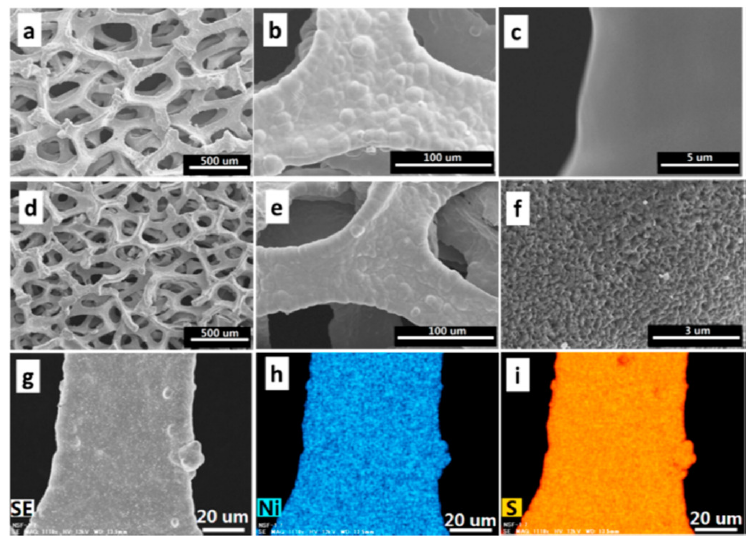
Figure 10. SEM images of ( a – c ) nickel foam and ( d – g ) nickel-sulfur foam at different magnifications. ( h ) Energy dispersive X-ray spectroscopy elemental mappings of nickel and ( i ) sulfur over image ( g ). Reproduced with permission from [84]. American Chemical Society, 2017.